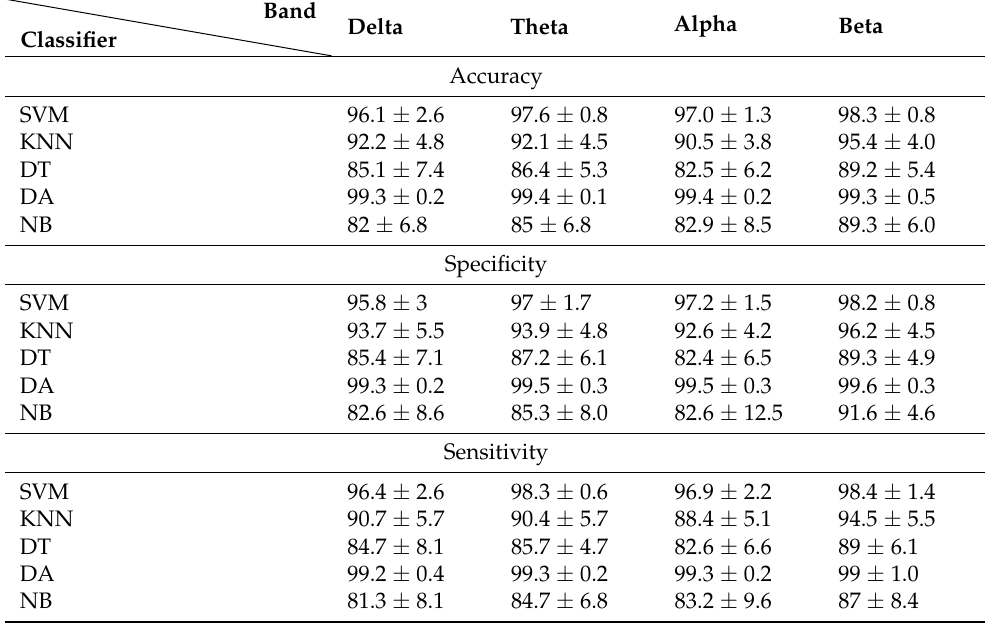
Table 2. The accuracy of subject-independent wICA-cleaned EEG-based vigilance